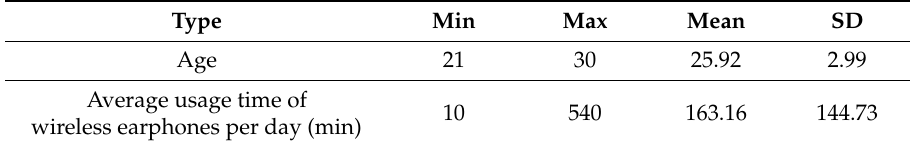
Table 5. Demographics I—participant characteristics.